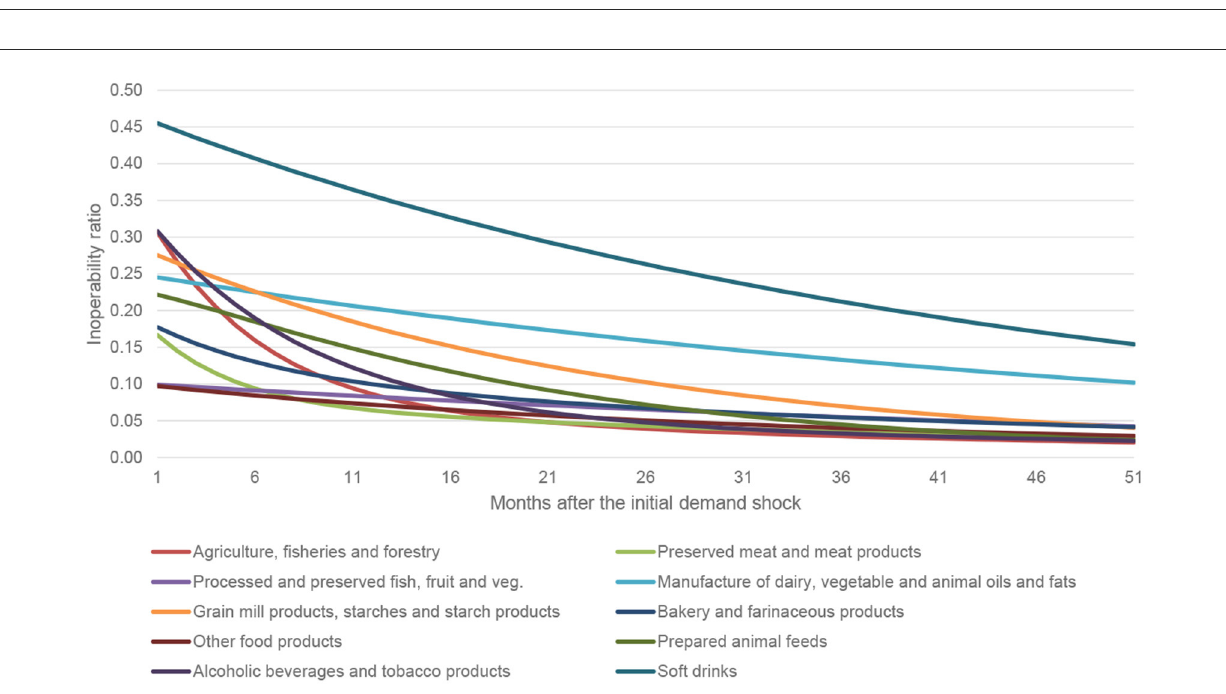
FIGURE6 Inoperability dynamic recovery path for agrifood sectors of the Scottish economy. Source: Own computation based on the Scottish input–output tables from 1998 to 2019.